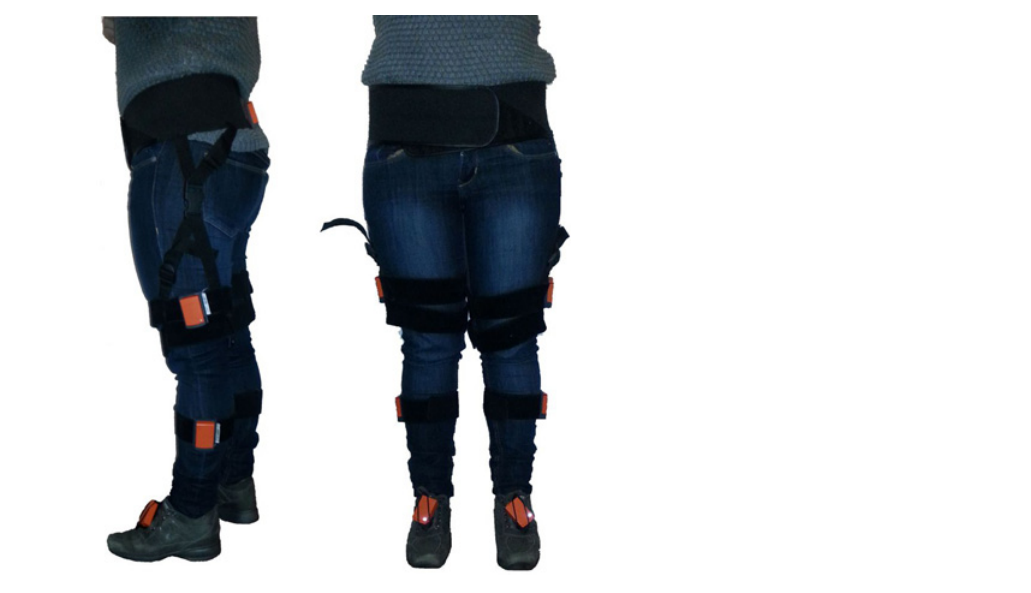
Fig 1. Position of each MIMU on one